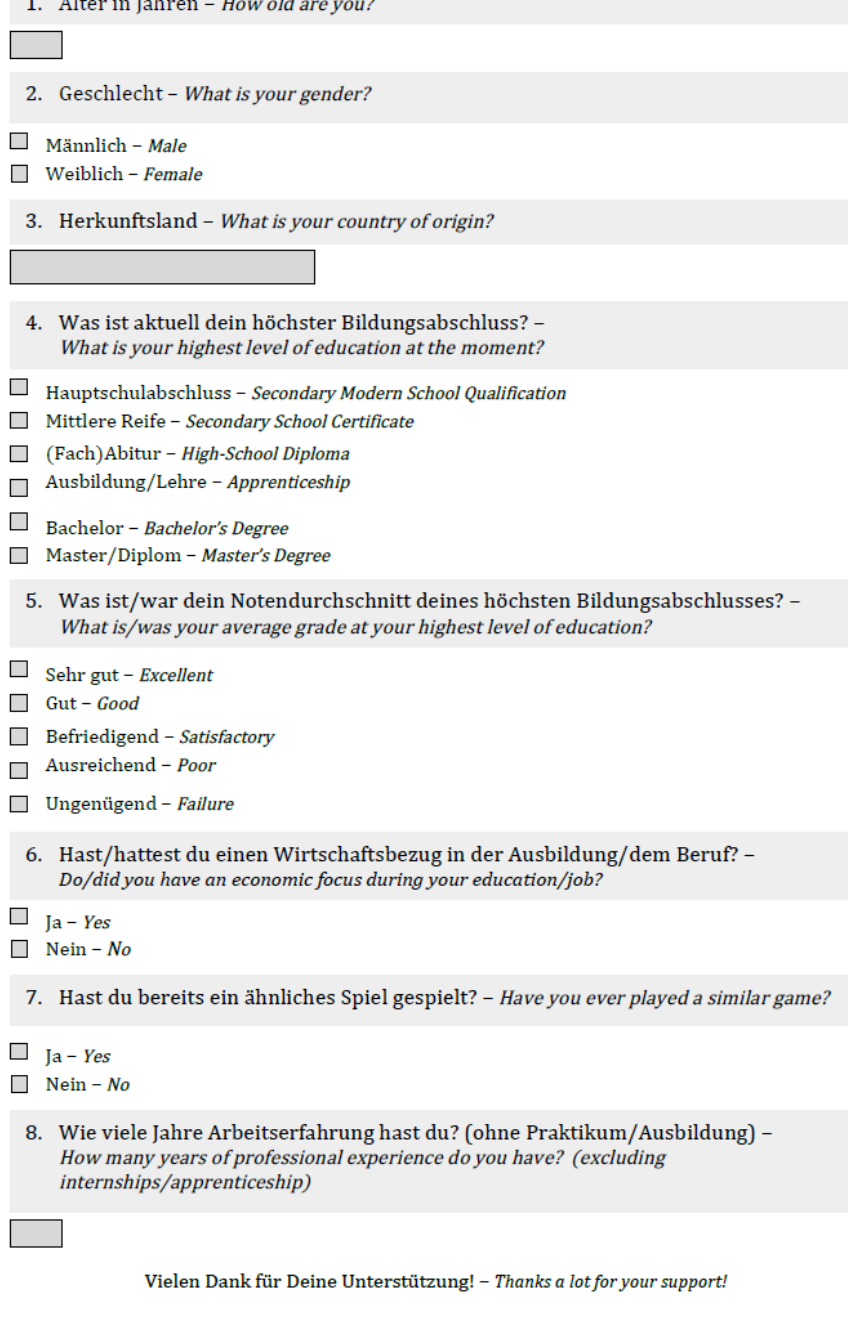
Figure A4. Questionnaire